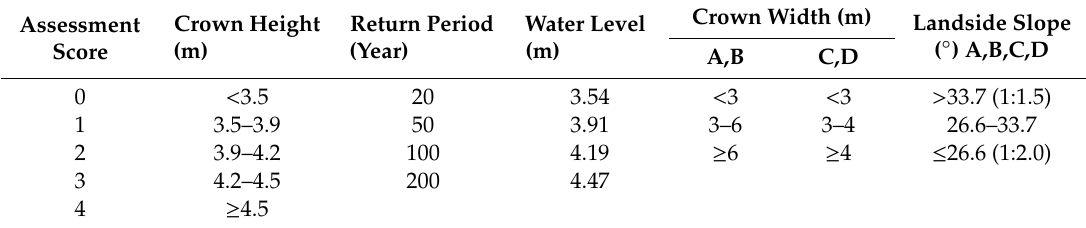
Table 2. The scoring sheet of levee stability and overtopping risk. The crown height intervals are set according to the flood stages (water levels) at four return